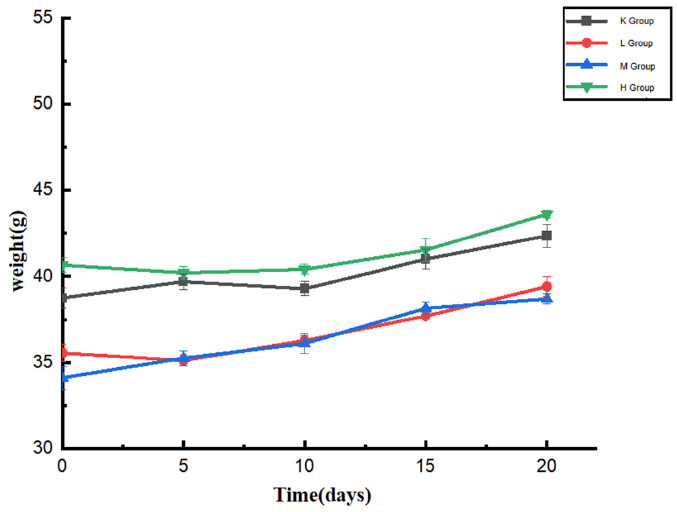
Figure 1. Changes in the body weights of mice during oral administration of anthocyanins from Opuntia ficus-indica. Table 1. Mouse Organ Ratio Index.